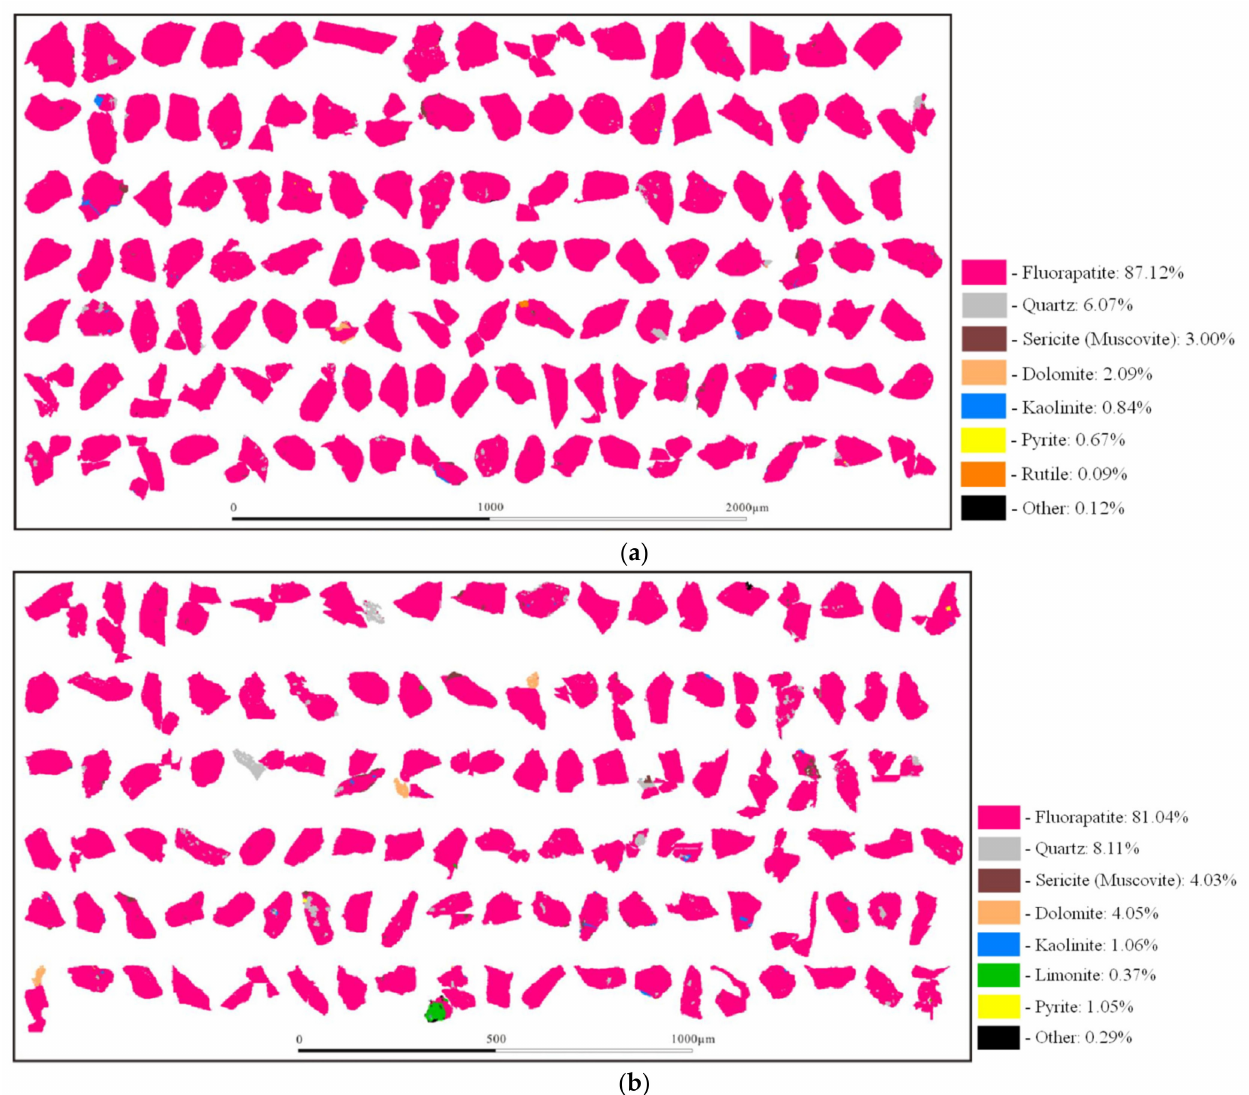
Figure 8. Intergrowth relationship between apatite and other minerals: ( a ) particle size of 75–212 µ m and ( b ) particle size of 38–75 µ